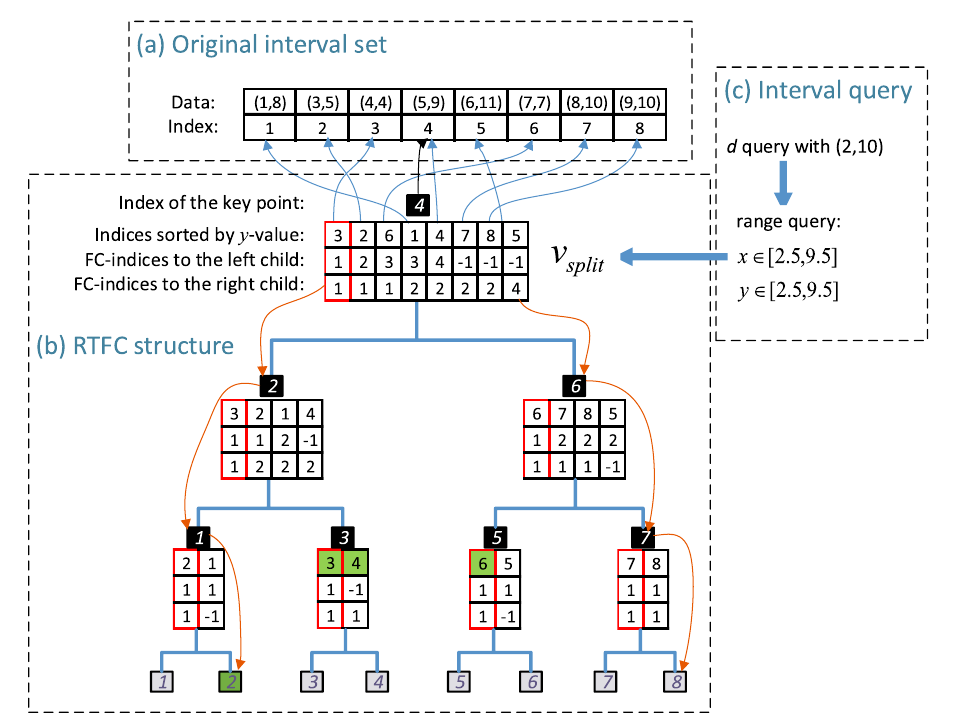
Figure 5. An example to illustrate the construction of RTFC and the query using RTFC. ( a ) The original interval set and the corresponding indices. ( b ) The resulting tree structure and the query processes. The red arrow lines represent the search path of x 1 = 2.5 and x 2 = 9.5. The item bounded by a red box in a node represents the searched index in the data array for y 1 = 2.5. The green shaded intervals represent the result intervals. ( c ) Range query transformed from interval